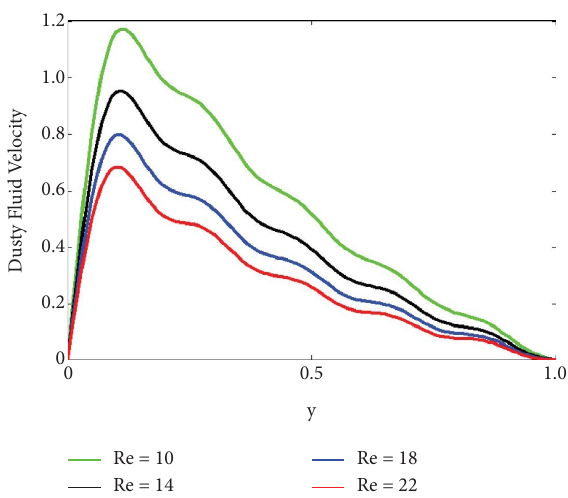
Figure 11: Te impact of diferent values of Re on ψ